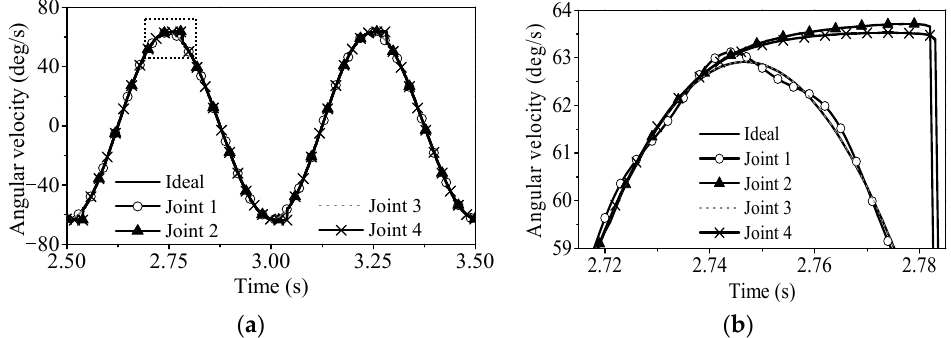
Figure 10. Angular velocity of the rigid system with different clearance joint position: ( a ) angular velocity; ( b ) partial enlarged drawing.